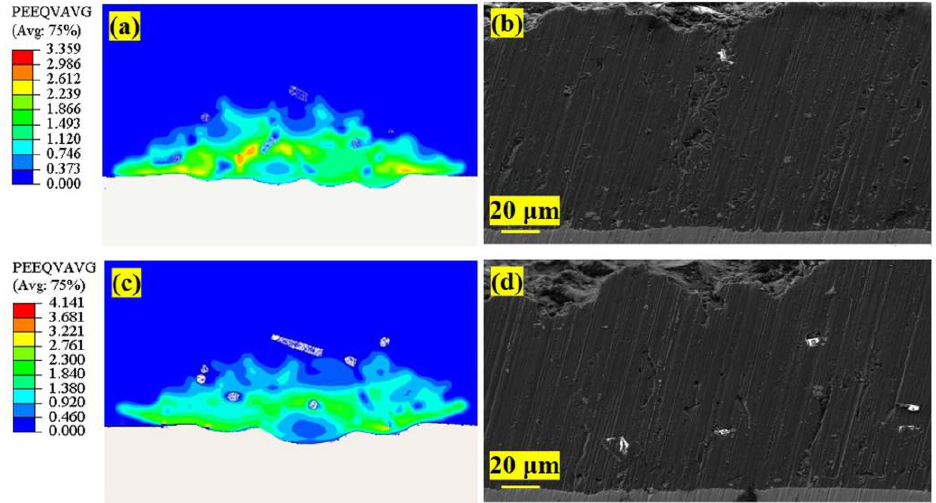
Figure 16. Composite coating cross-section: ( a ) 15 vol.% CBF simulation cross-section; ( b ) SEM picture of 15 vol.% CBF cross-section; ( c ) 30 vol.% CBF simulation cross-section; ( d ) SEM picture of 30 vol.% CBF cross-section.